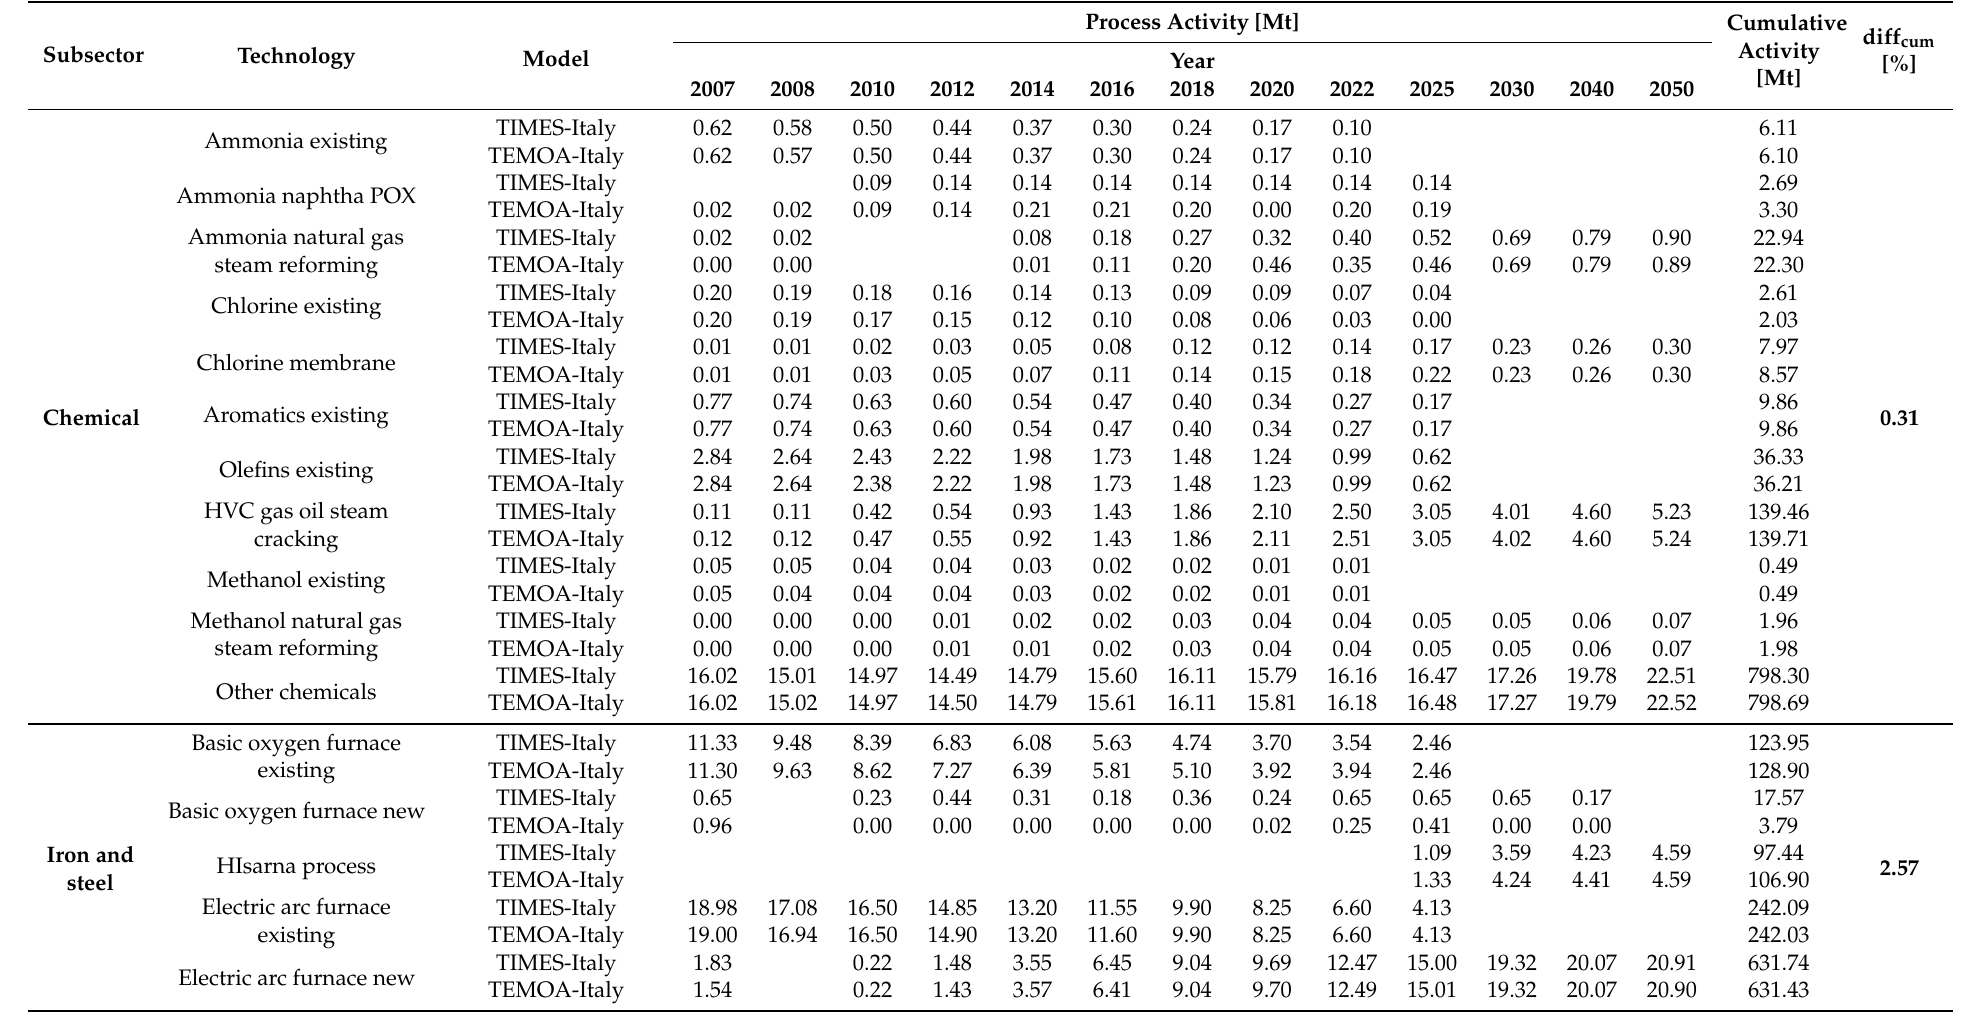
Table A5. Activity of final technologies producing industrial service demands and cumulative activity along the entire time horizon, compared for TIMES-Italy